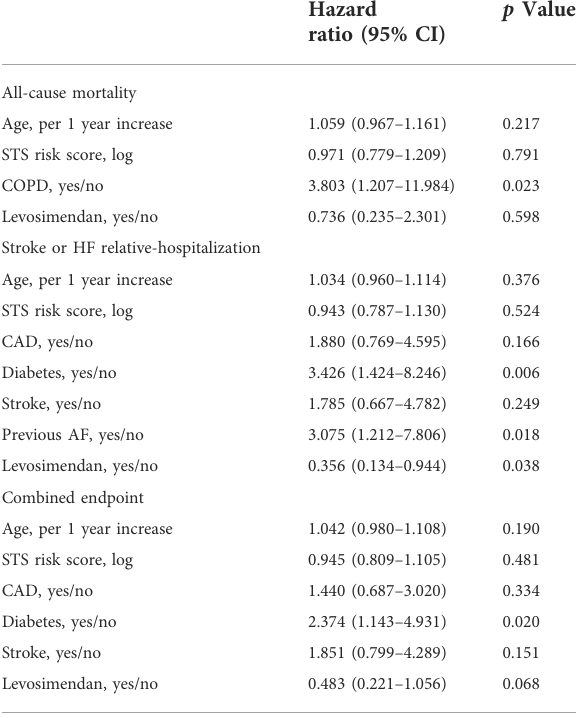
TABLE 3 Multivariable cox proportional hazard